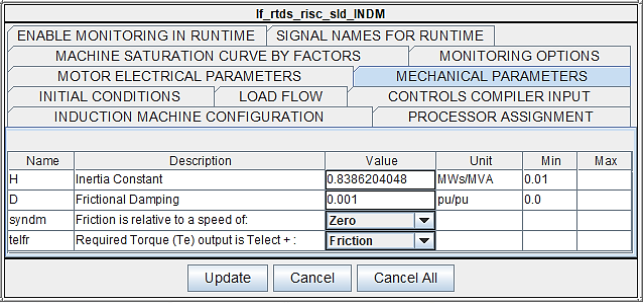
Figure 17. Squirrel - cage induction generator model mechanical parameter settings. Figure 17. Squirrel-cage induction generator model mechanical parameter